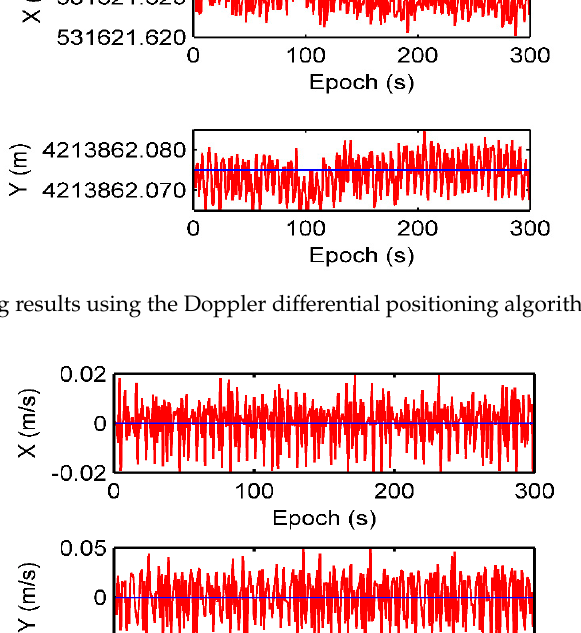
Figure 6. Velocity estimation results using the Doppler differential positioning algorithm in the static test. Table 2. Average value (AVG) and standard deviation (STD) of Doppler differential measurements in the static test.